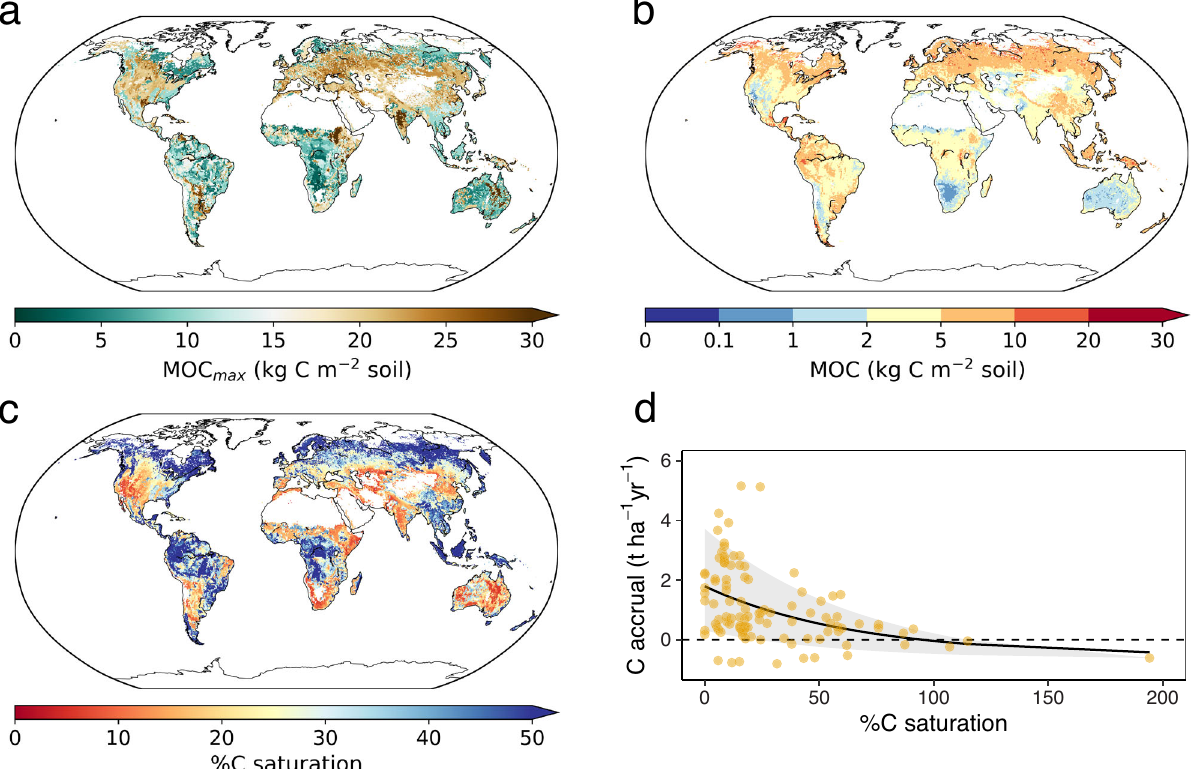
Fig. 4 Global soil mineralogical carbon capacity, mineral-associated carbon stocks, and potential for carbon accrual. a Mineralogical carbon capacity (MOC max ; kg C m − 2 soil), b mineral-associated organic carbon (MOC; kg C m − 2 soil), and c percent mineralogical carbon saturation (%C saturation) in topsoil (0 – 30 cm) at 0.5° resolution, excluding tundra, peatlands, and deserts. MOC max was estimated using our data-derived relationships with the amount and type of mineral. MOC was predicted using a random forest model trained on our observational dataset. %C saturation was calculated as MOC/MOC max . Low %C saturation corresponds to a greater C de fi cit, and therefore highlights regions where targeted soil management could lead to higher C sequestration. d Carbon accrual in topsoil (t ha − 1 yr − 1 ; mean depth = 29 cm) as a function of %C saturation across sites, based on our global synthesis of studies that measured C accrual following management interventions ( n = 103). Nonlinear fi t depicts asymptotic regression model with shaded areas representing 10th and 90th